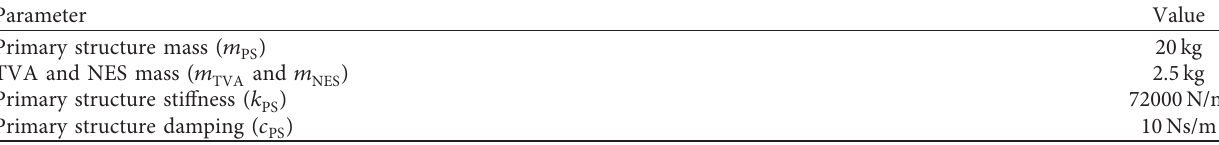
Table 1: System parameters.